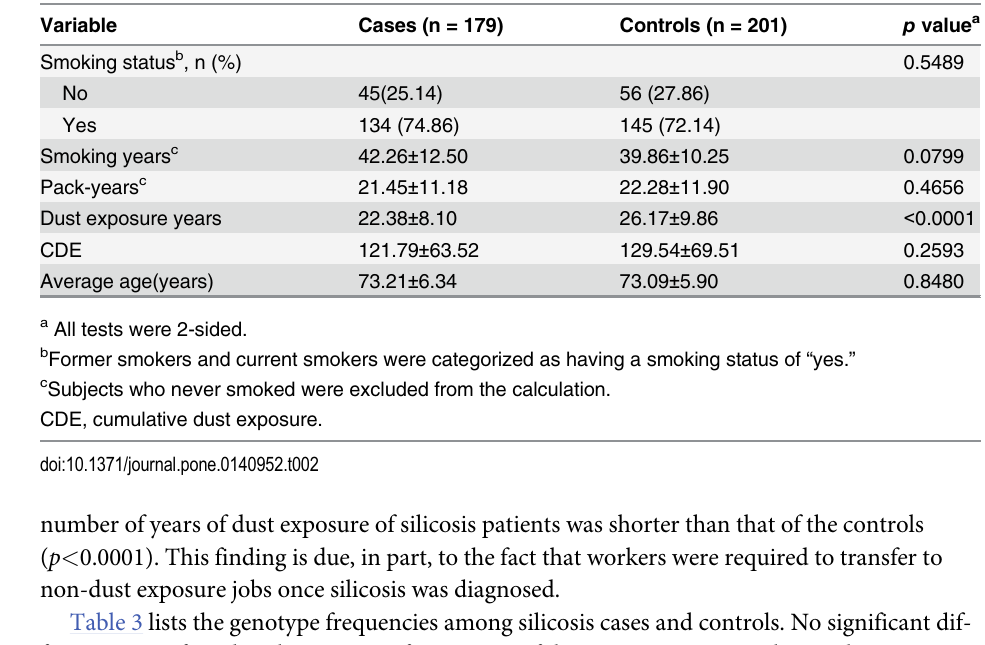
Table 2. Lifestyle and occupational characteristics of patients with silicosis and control subjects.